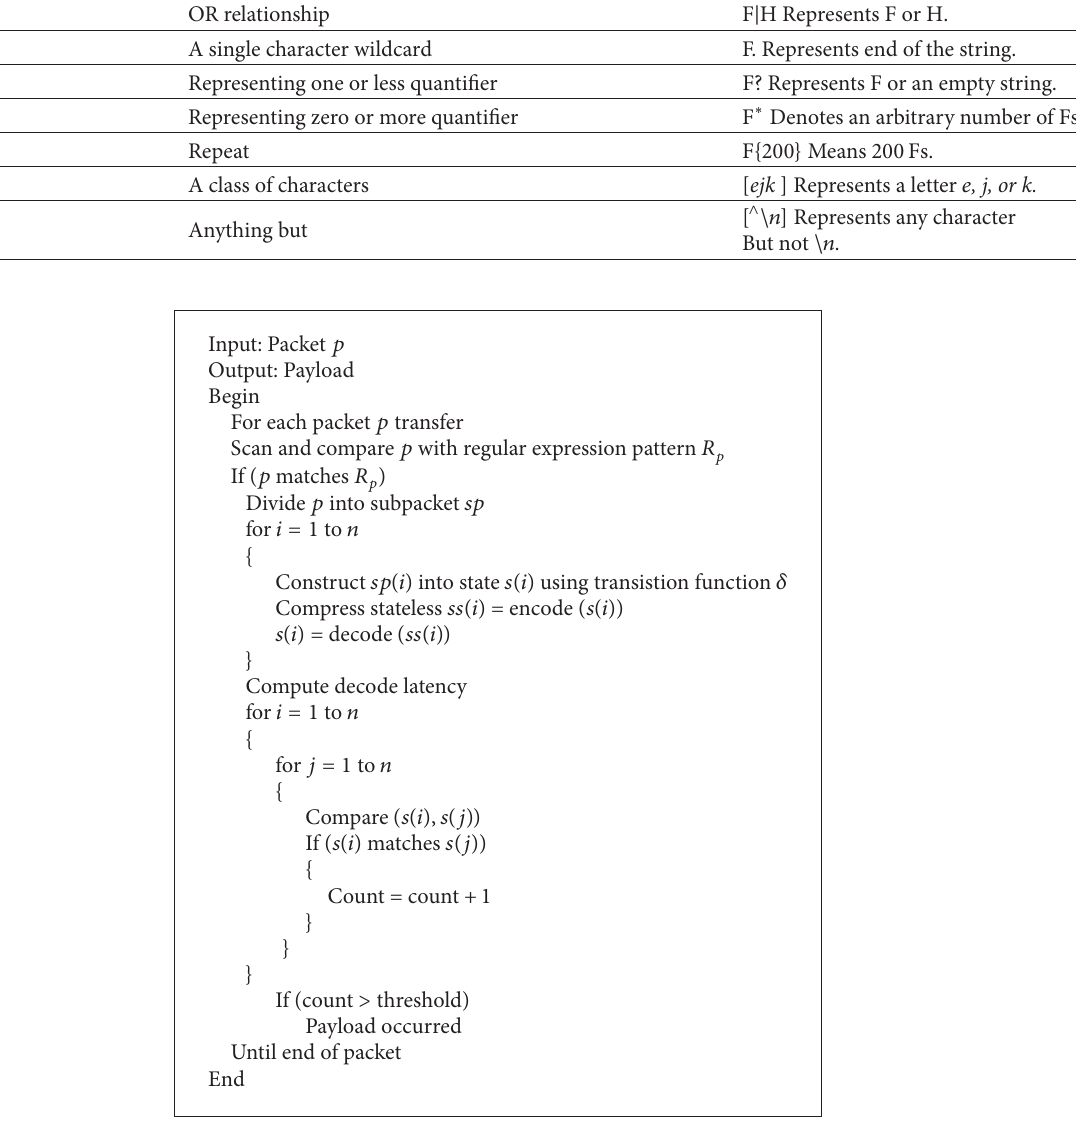
Pseudocode 1: Pseudocode for proposed